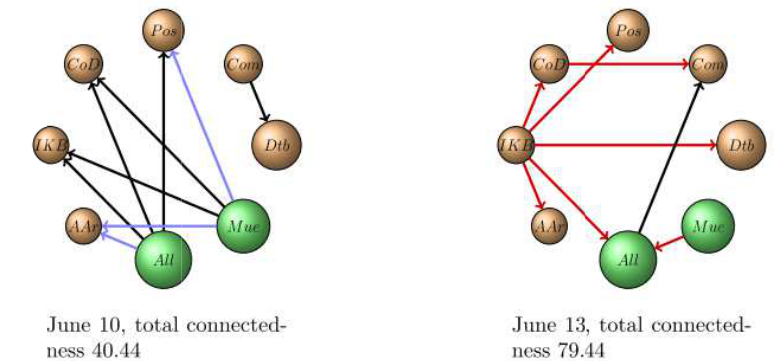
Fig. 5. We pl 10, the blu